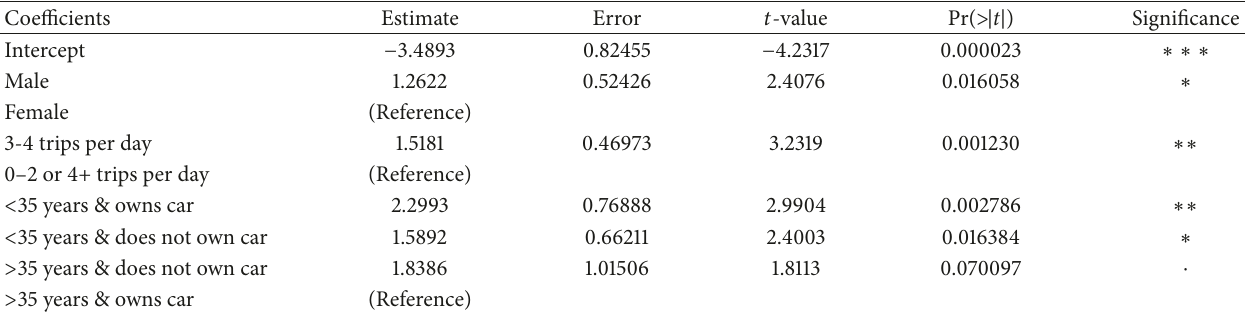
Table 2: Logit model for willingness to use shared autonomous